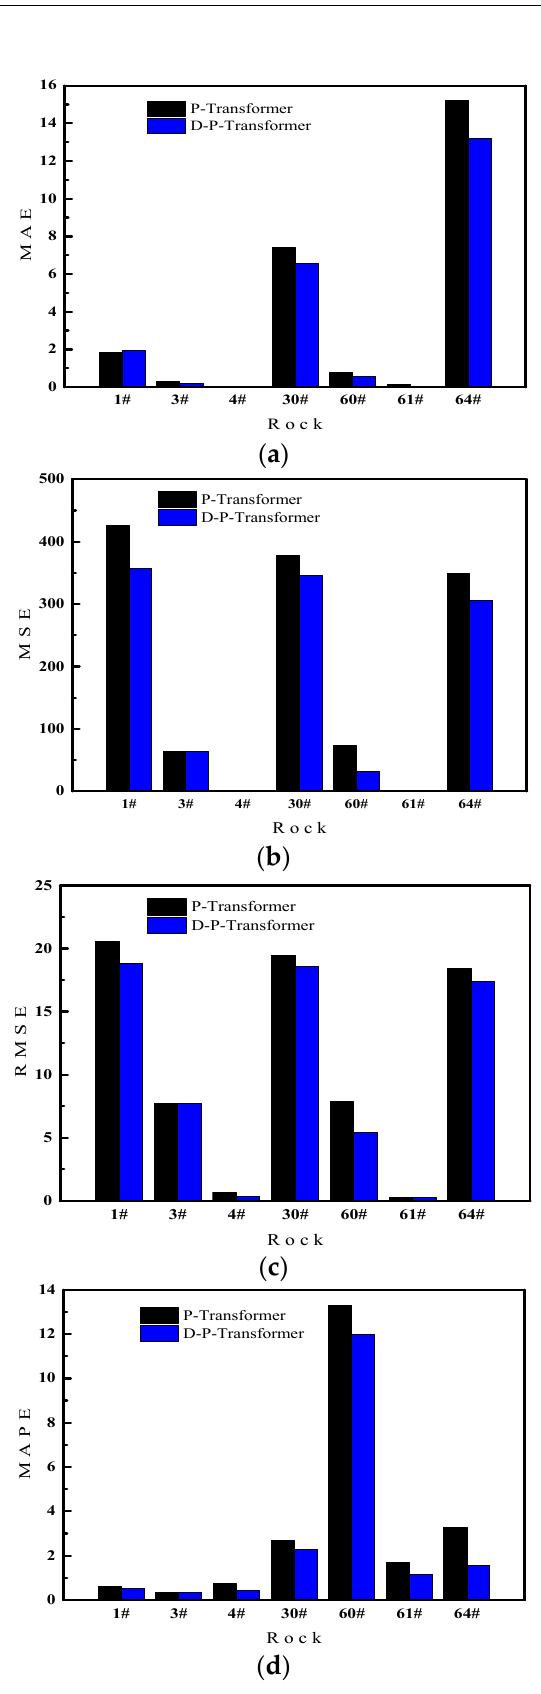
Figure 7. The metrics of the D-P-Transformer and P-Transformer algorithms: ( a ) MAE; ( b ) MSE; ( c ) RMSE; ( d ) MAPE.